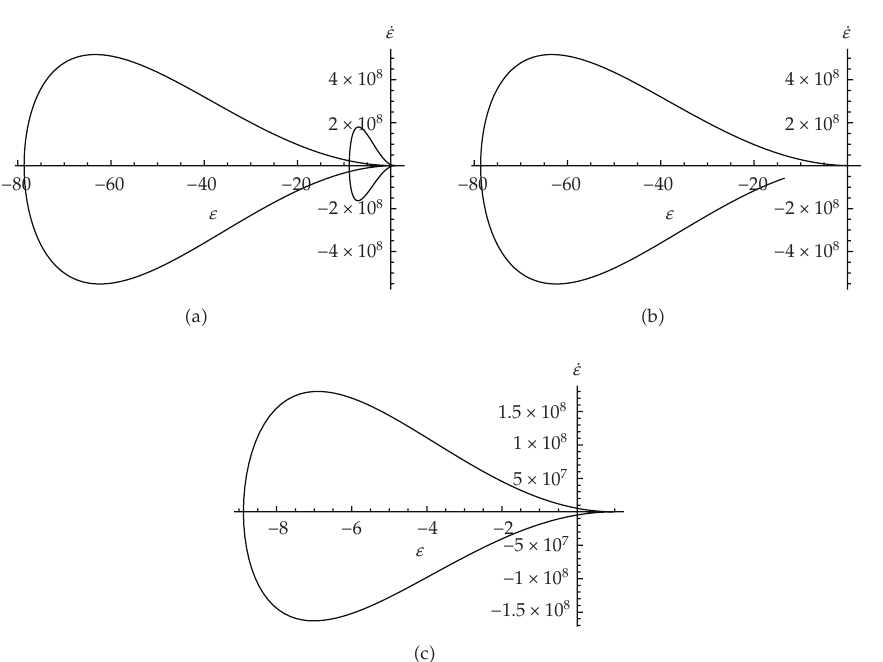
Figure 9: See the caption of Figure 8 which applies to both Figures 8 and